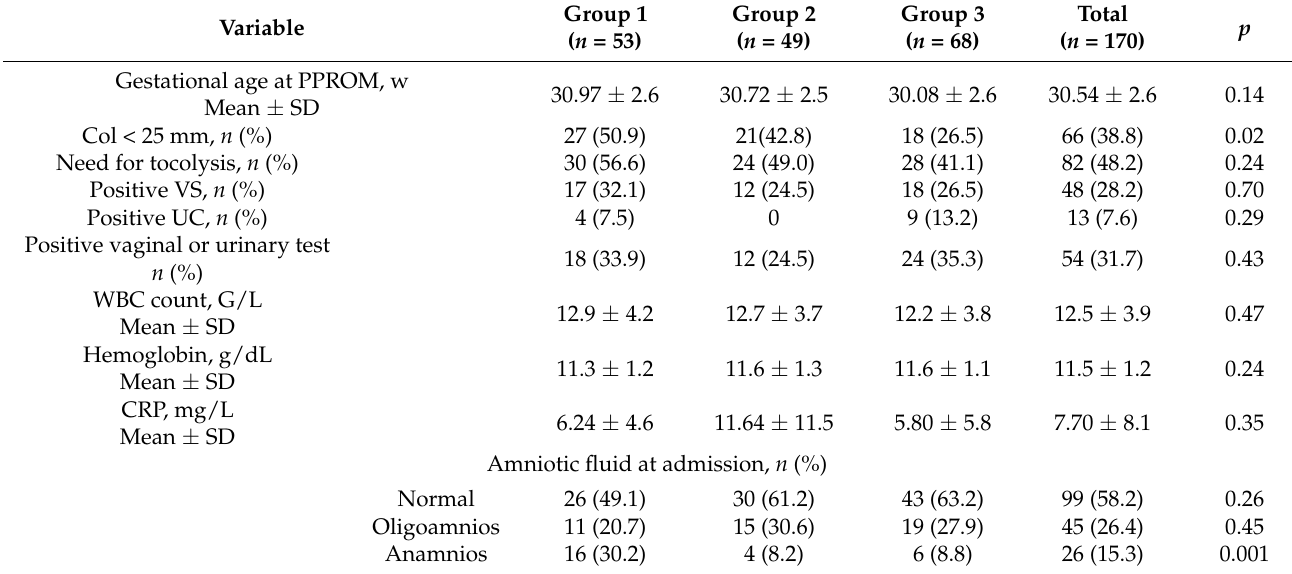
Table 3. Admission